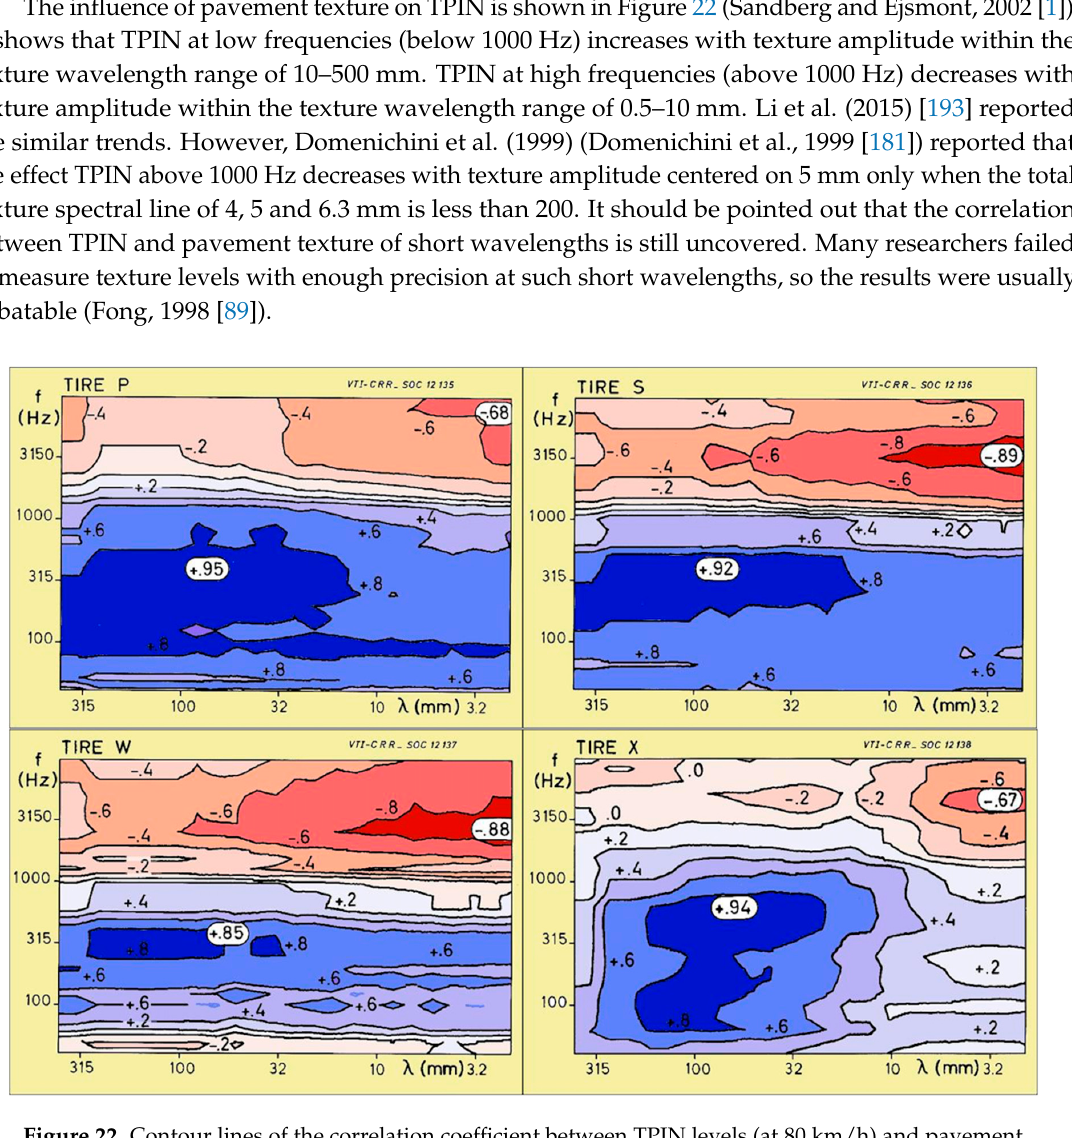
Figure 22. Contour lines of the correlation coefficient between TPIN levels (at 80 km/h) and pavement texture levels for four different tires (source from Sandberg and Ejsmont, 2002 [1], Figure 11.6; reprinted with permission from Dr. Ulf Sandberg of VTI, Sweden).